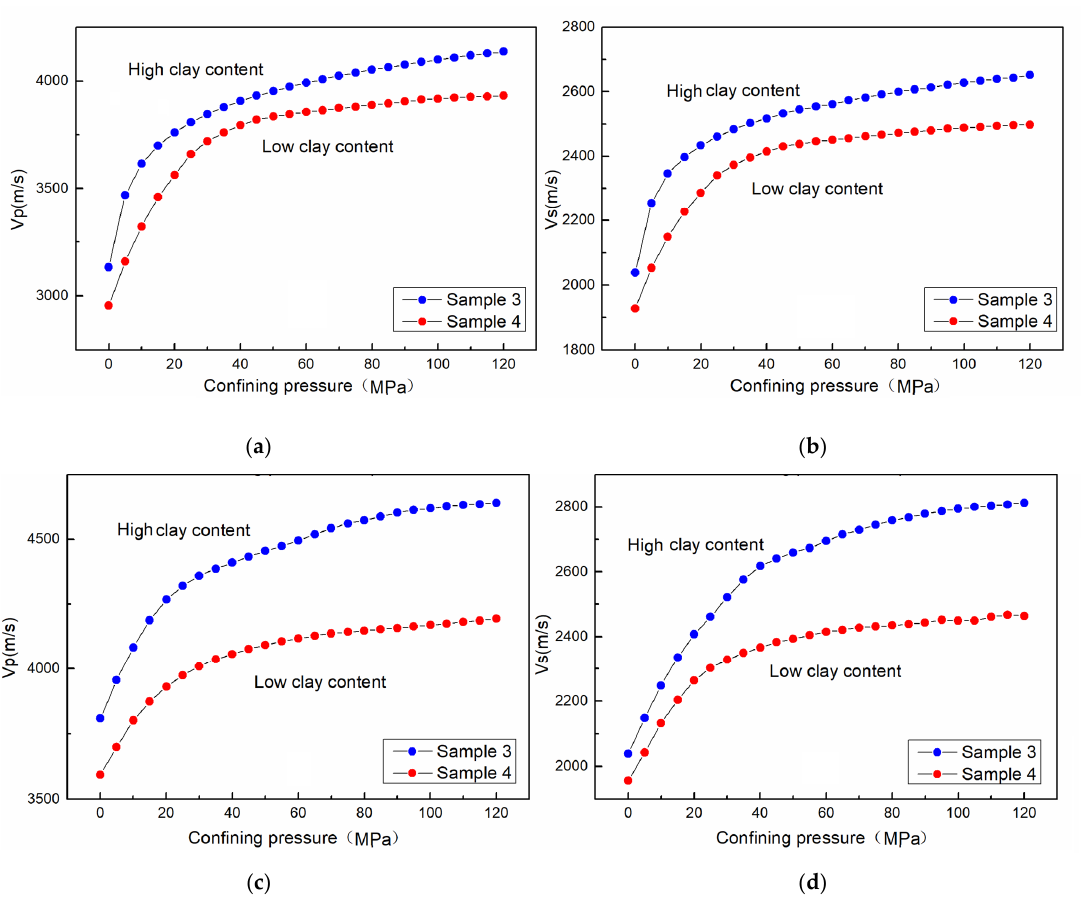
Figure 9. Relationship between P- and S-wave velocity and confining pressure, ( a , b ) are the rela- tionship between wave velocity and pressure under dry conditions, and ( c , d ) are the relationship between wave velocity and pressure under completely saturated conditions.